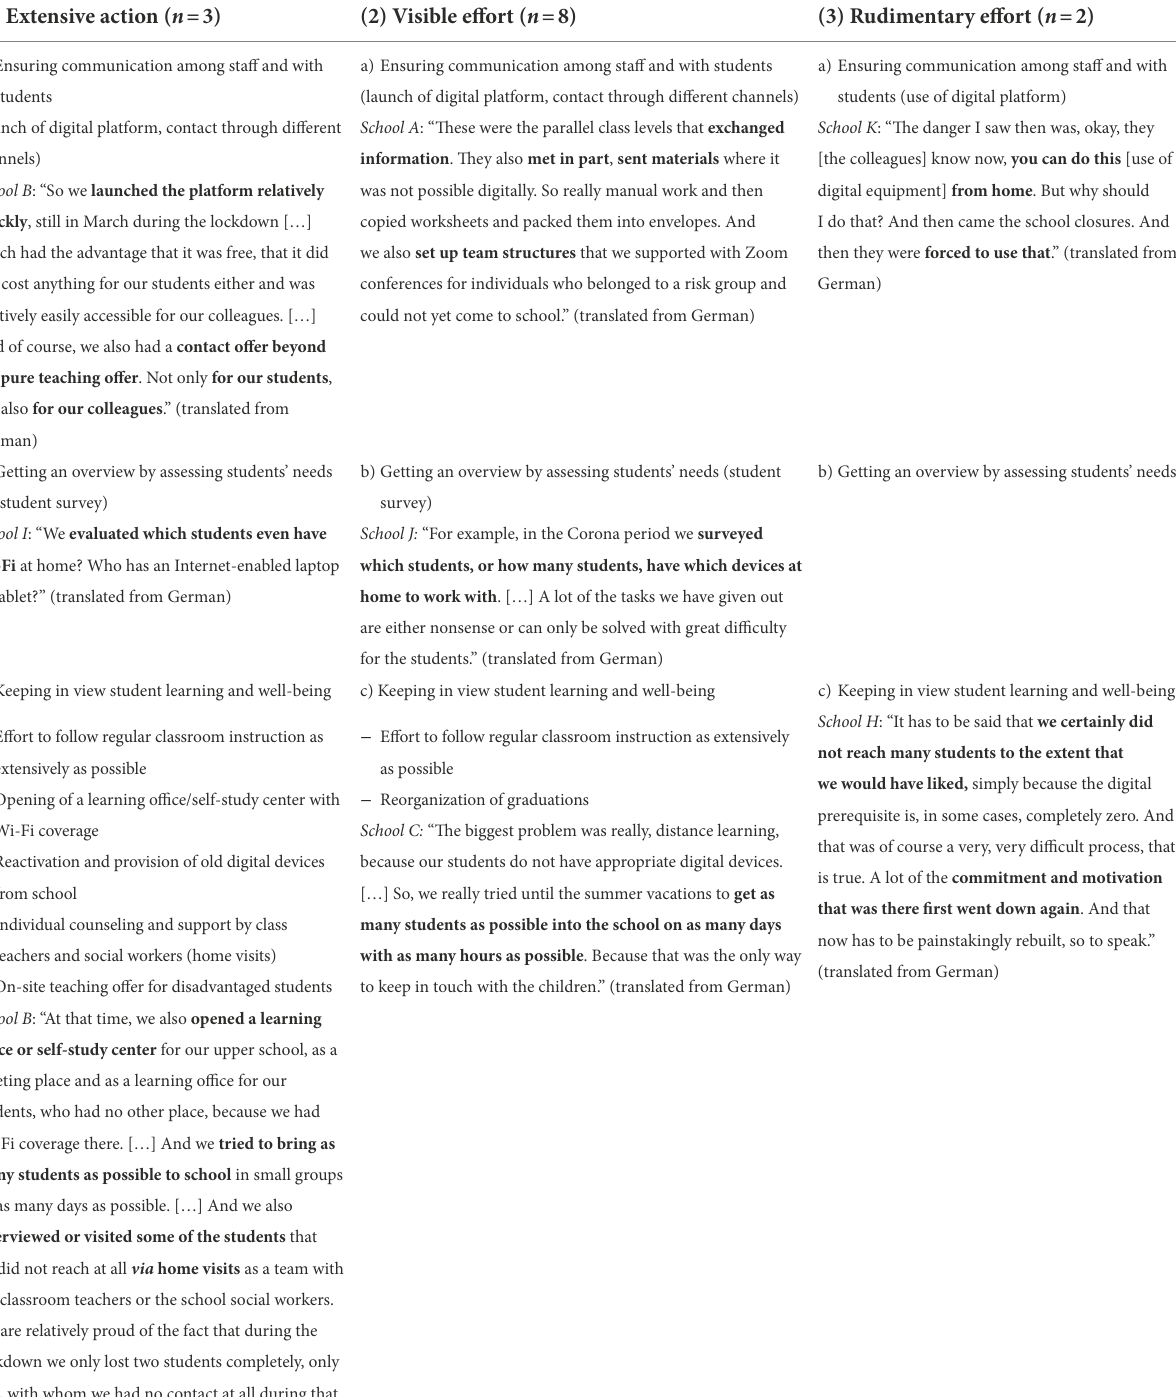
TABLE 5 Response patterns to school